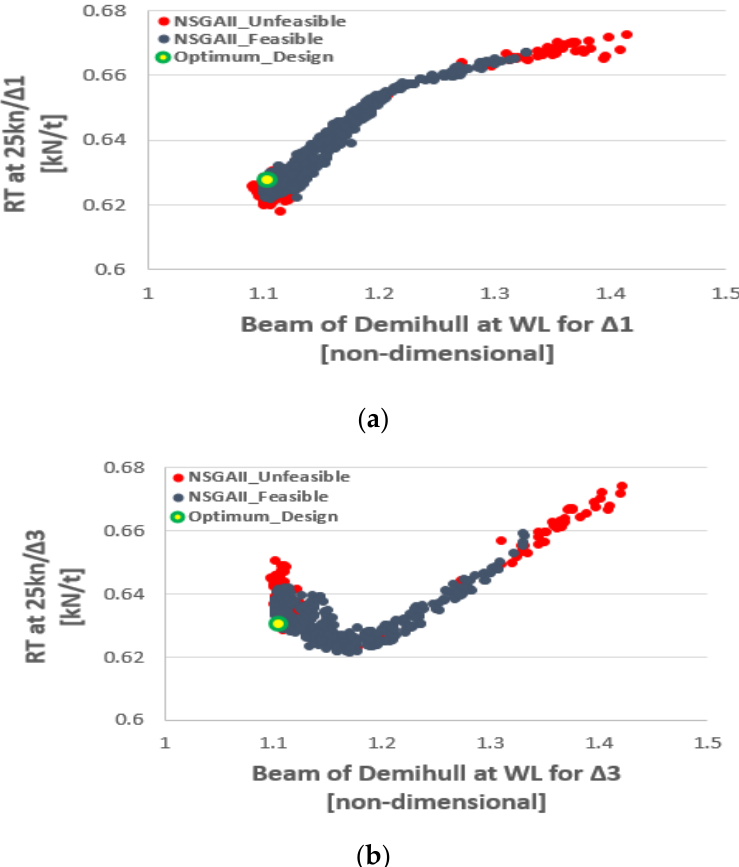
Figure 6. Calm water resistance per ton of displacement against nondimensional beam at WL at 21 kn for ( a ) Δ1 and ( b ) Δ3.